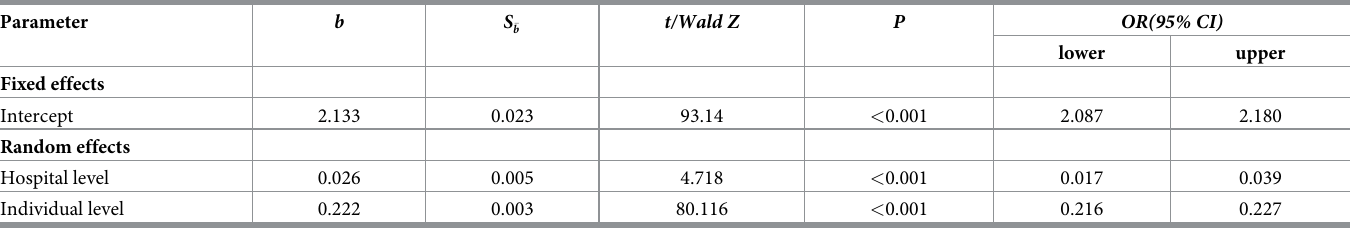
Table 2. Summary of multilevel empty